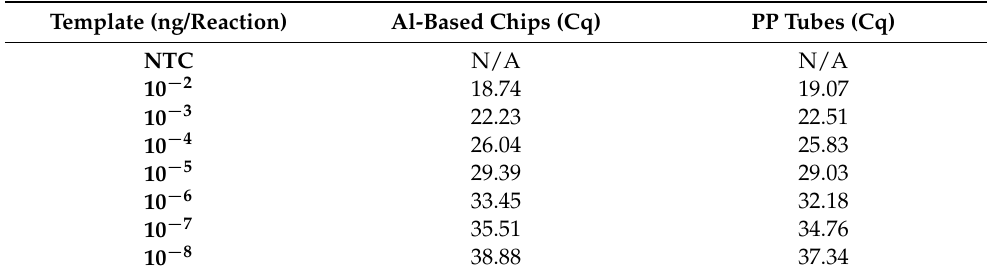
Table 2. Cq values of real-time PCR tests with different template concentrations in aluminum-based chips and control